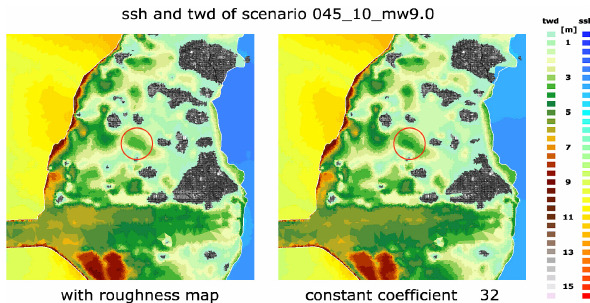
Fig. 6. Sea surface height (seaside) and total water depth (upon land) for a scenario of earthquake magnitude 9 (045 10 mw9.0). Left: with detailed roughness map, right: with constant Manning value M =32m 1 / 3 /s everywhere.